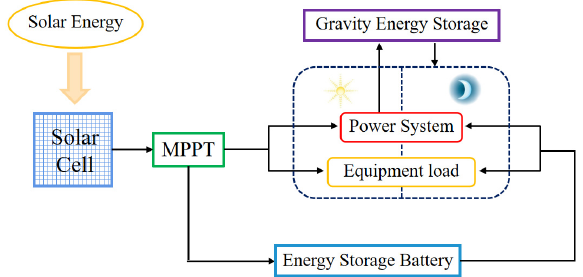
Figure 2. Energy transmission path of solar-powered UAV.